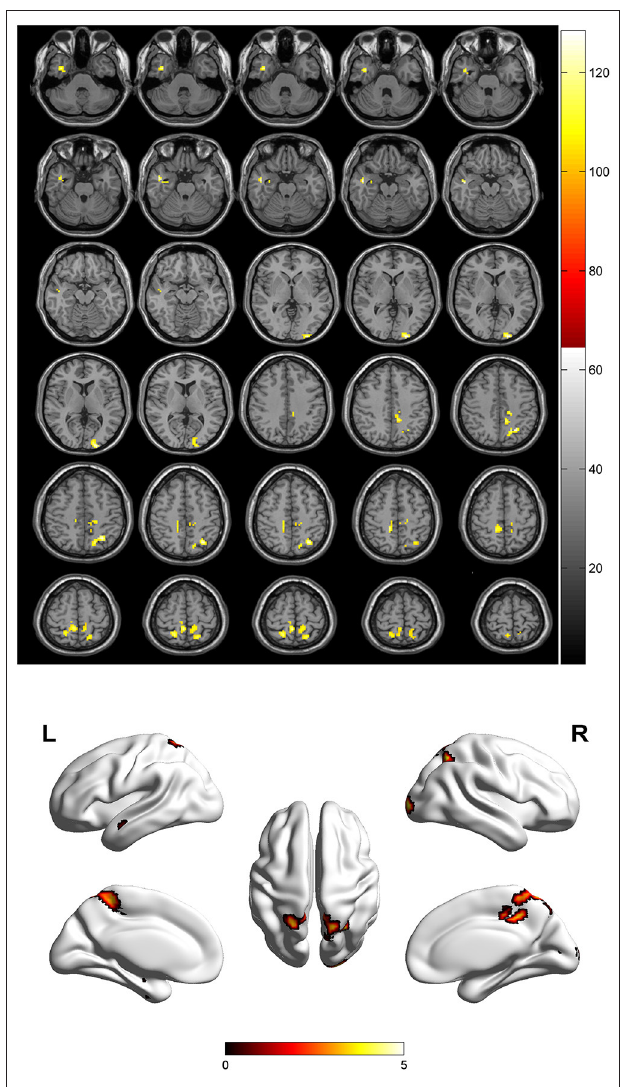
FIGURE 1 | Spontaneous brain activity in patients with DOP group vs. Control group. The threshold was set p < 0.01(FDR correction).